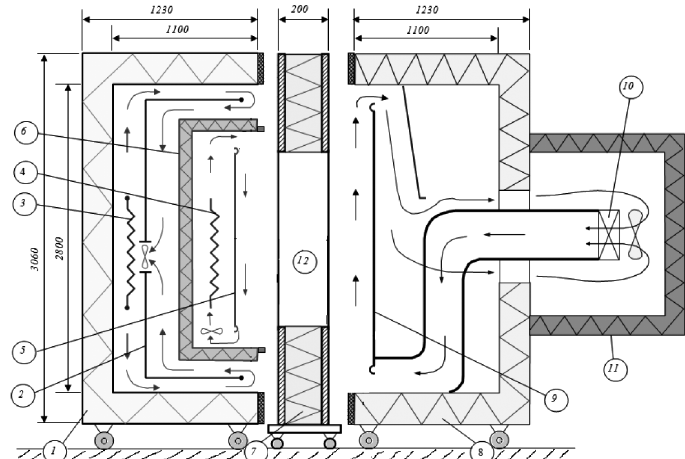
Figure 1. Cross-section of the Hot Box; 1 − Warm guard box; 2 − Protective galvanized pane metal shield for airflow distribution around metering box; 3, 4 − Electric coil heater; 5 − Metering box baffle; 6 − Metering box; 7 − Surround panel; 8 − Cold side box; 9 − Cold side box baffle; 10 − Cooling unit of cold side box; 11 − Air make-up section of cold side; 12 – opening for